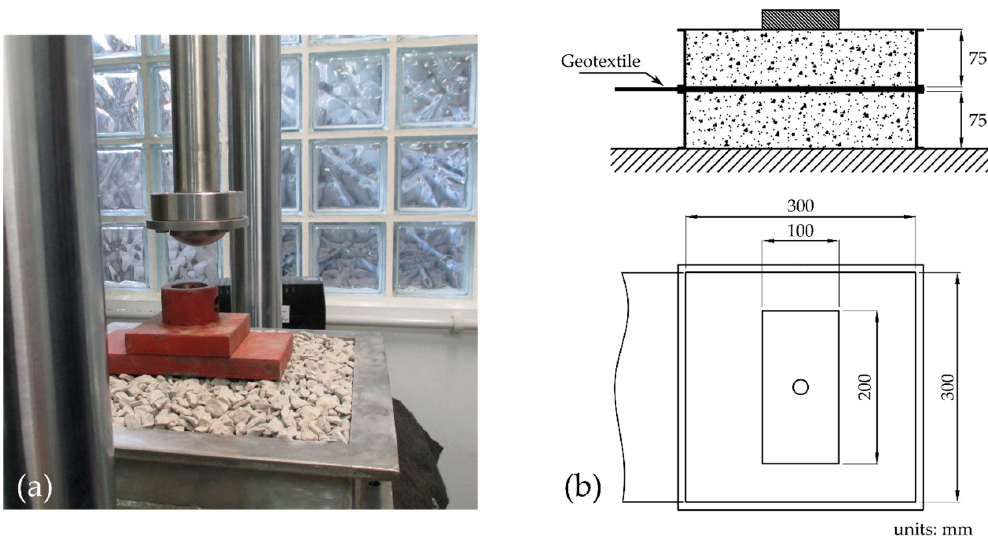
Figure 5. Modified ISO 10722 test carried out in the laboratory. ( a ) Photography; and ( b ) schematic drawing (modified from [17]).